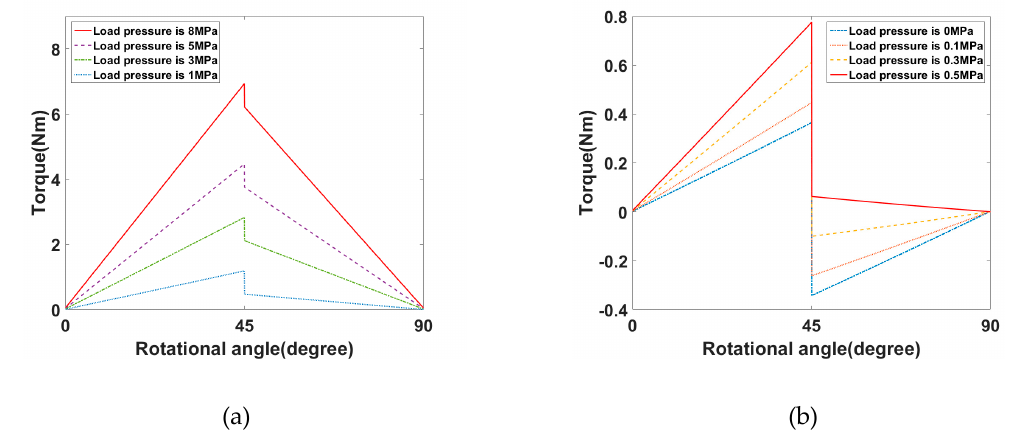
Figure 14. Input torque distribution of the driving set under different load pressures at 5000 rpm. ( a ) Normal load pressures; ( b ) relatively low load pressures.